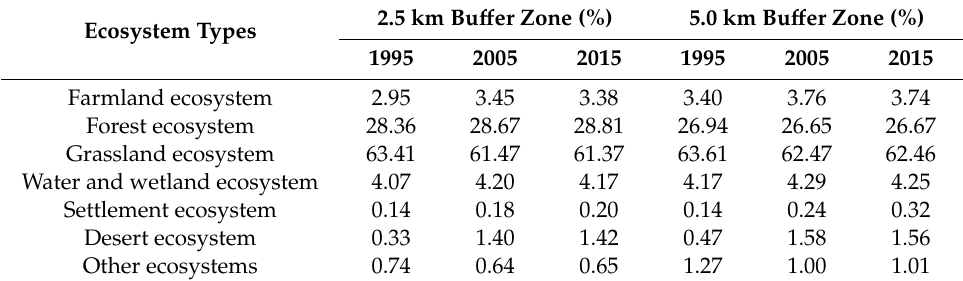
Table 7. Percentage of di ff erent ecosystem types in 2.5 and 5.0 km corridor bu ff er zones.